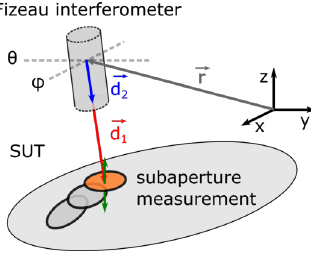
Figure 4. Positioning the topographies from the subaperture measurements: The Fizeau interferometer position ( ~ r ,φ , θ ) rel- ative to the local surface under test (SUT) is known from the mo- tion system. The subtopographies are positioned with the mea- sured absolute distance ~ d 1 from the reference flat to the SUT and the distance ~ d 2 from the pivot point to the reference flat. The green arrow depicts the z-direction in which the topographies are